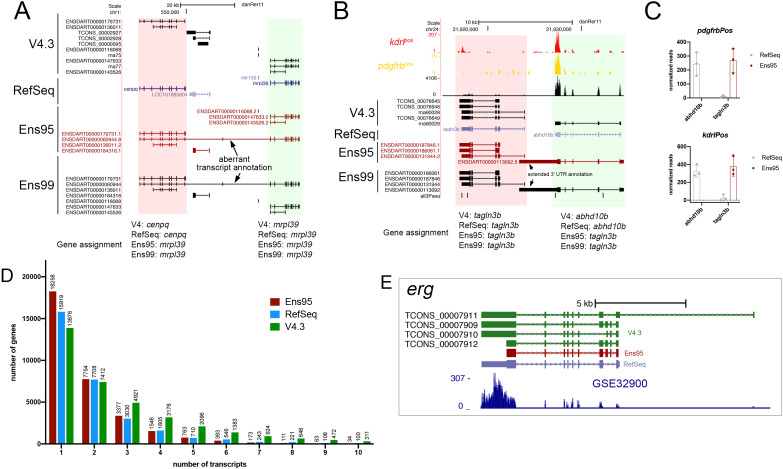
Ensembl naming conflicts and improved transcript diversity in V4.3.(A, B) Annotated UCSC Genome Browser screenshots of (A) cenpq and mrpl39 loci and (B) talgn3b and abhd10b loci. RefSeq, Ens95, Ens99 and V4.3 transcript annotations are shown. Ensembl-annotated transcripts overlapping adjacent locus and leading to misassignment of gene names are indicated. (C) Apparent detected expression for abhd10b and tagln3b in pdgfrbpos RNA-seq reads (n = 3) using indicated annotation. Error bars denote SEM. The abhd10b transcripts are annotated as belonging to the tagln3b gene in Ensembl95 and 99. This leads to a failure to detect abhd10b when using Ensembl annotations, along with spurious inflation of tagln3b expression levels due to the inclusion of reads that should be mapped to abhd10b. (D) Histogram plot of numbers of transcripts per gene for indicated annotation. The plot is limited to genes with 10 or fewer transcripts. (E) UCSC browser image of the erg locus showing transcripts from indicated annotation and mapped reads from GSE32900.